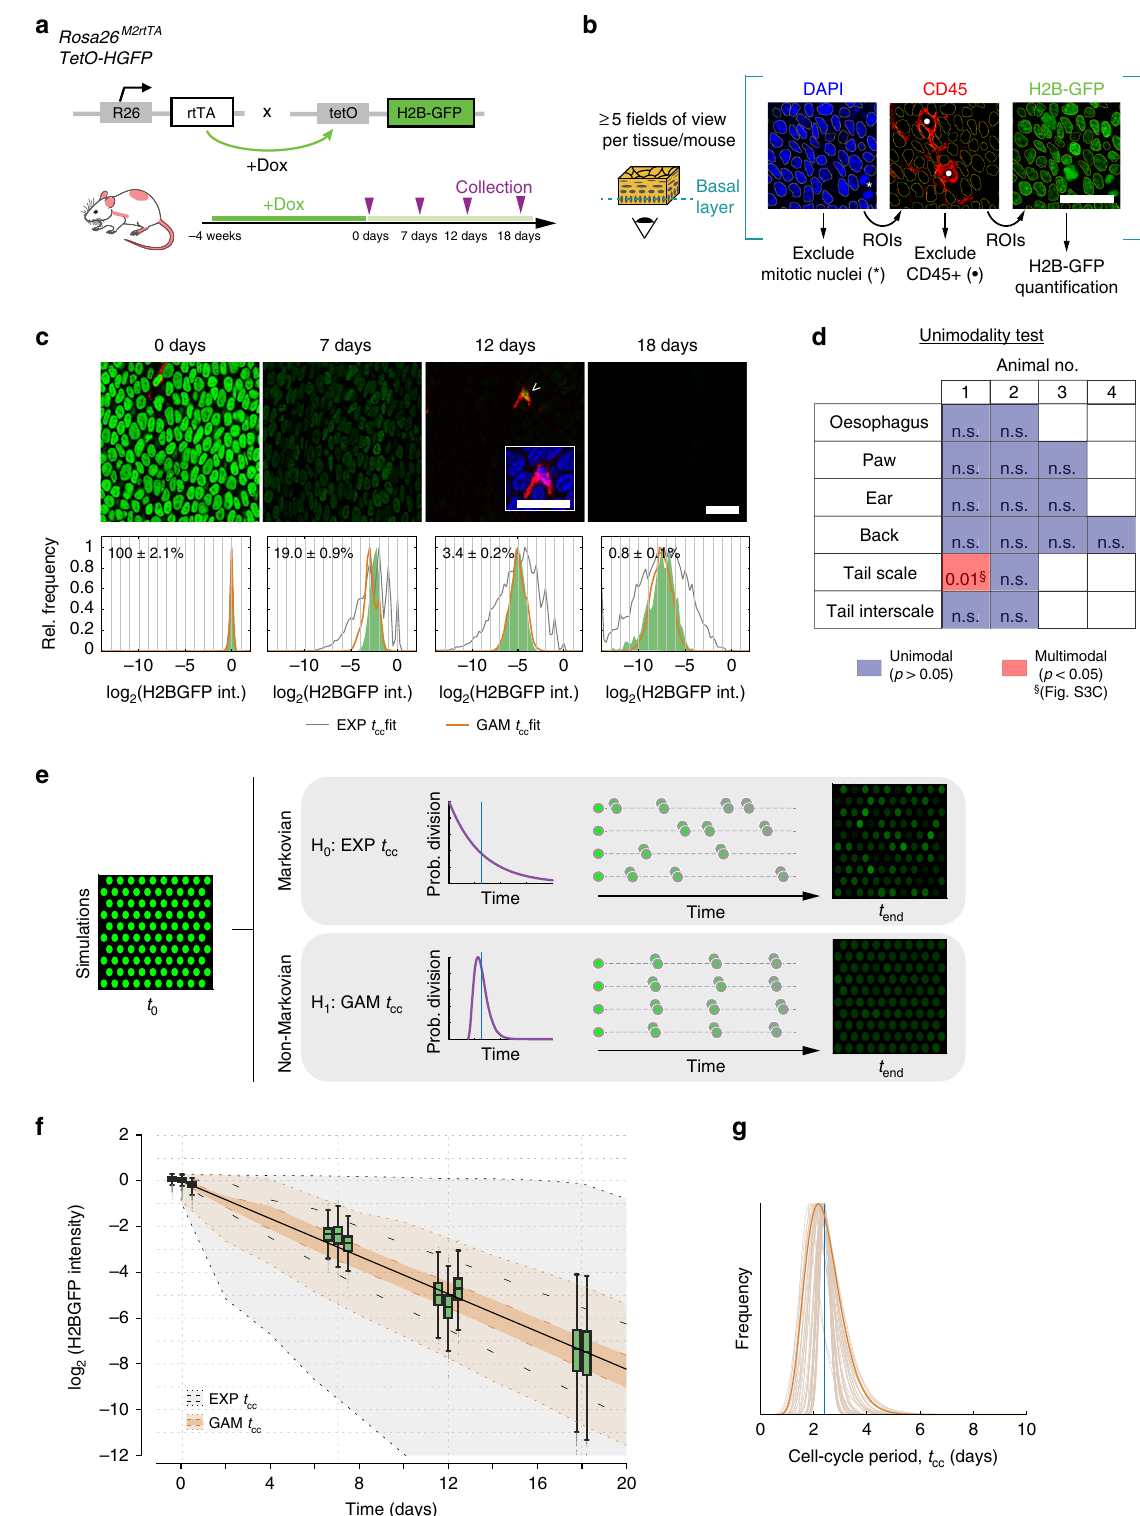
Clonal dynamics in esophageal epithelium . In order to explore in vivo clonal dynamics, we began by studying a lineage tracing data set from mouse esophageal epithelium (Fig. 7a). In this experiment we used a strain ( Lrig1-cre) in which a tamoxifen- regulated form of Cre recombinase and enhanced green fl uor- escent protein (EGFP) are targeted to one allele of the Lrig1 locus 8,23 – 25 . We found LRIG1 protein was ubiquitously